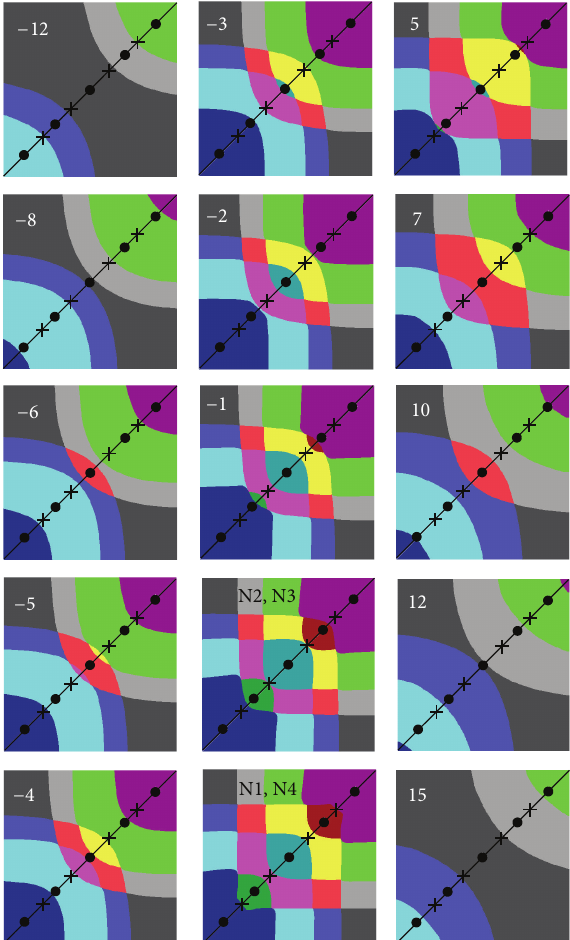
Figure 6: The projections of cross-sections into 𝑢 2 , 𝑢 1 plane for the parameters (4) and current denoted in the figure (in mA).